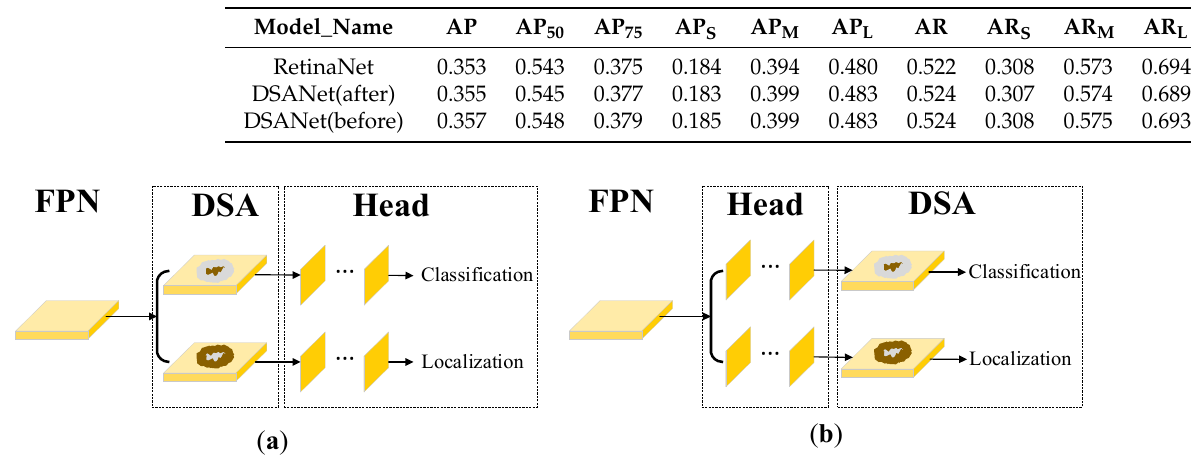
Table 3. Comparison of different DSA module location. DSANet(before) represents the location of DSA modules between backbone and head network, and DSANet(after) represents the location of DSA modules after head network.